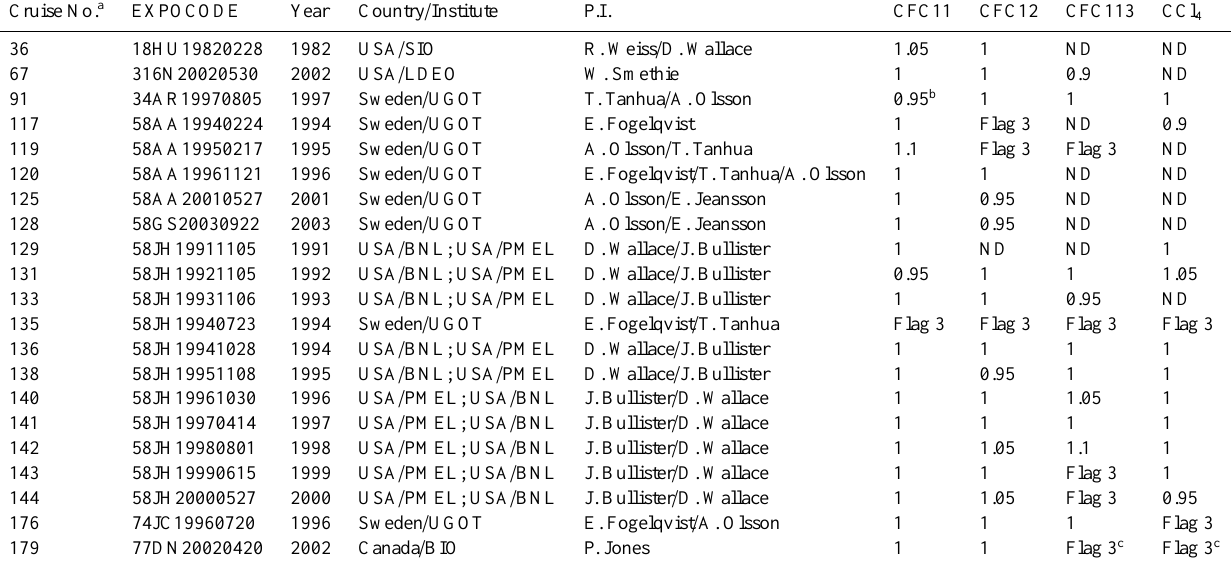
Table 1. CARINA cruises with CFC data in the Nordic Seas. ND denotes “no data”, i.e. the parameter was not measured. Adjustments for the CFCs are multiplicative and the presented numbers been applied in the merged data product. Flag 3 means that the data are of questionable quality and are not included in the merged data product.